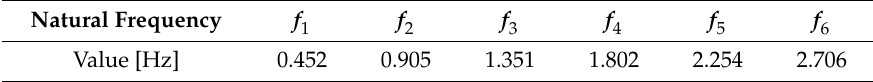
Table 1. Numerical natural frequencies of the